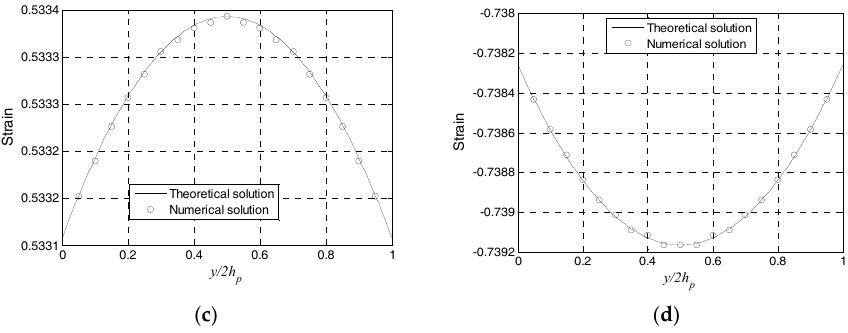
Figure 4. Theoretical and numerical solutions of the PZT strain distribution along the y direction. ( a ) The excitation frequency is 1 kHz; ( b ) The excitation frequency is 10 kHz; ( c ) The excitation frequency is 30 kHz; and , ( d ) The excitation frequency is 50 kHz.